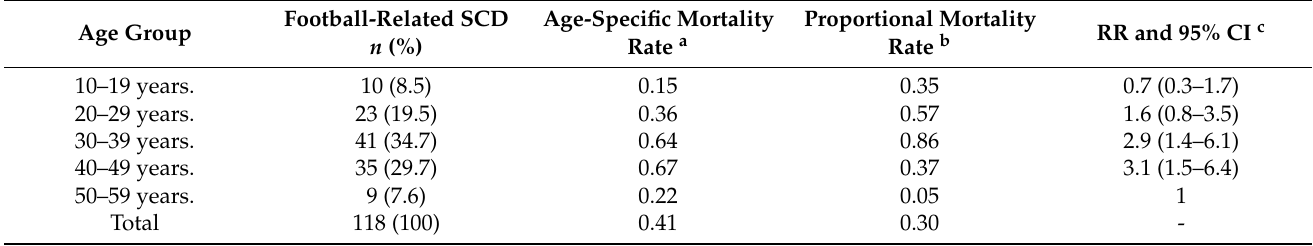
SCD: sudden cardiac death, RR and 95% CI: relative risk and 95% confidence interval. a Age-specific mortality rate was calculated in units of deaths per 100,000 ratio of the number of football-related sudden cardiac death among those aged 10–59 years to the number of